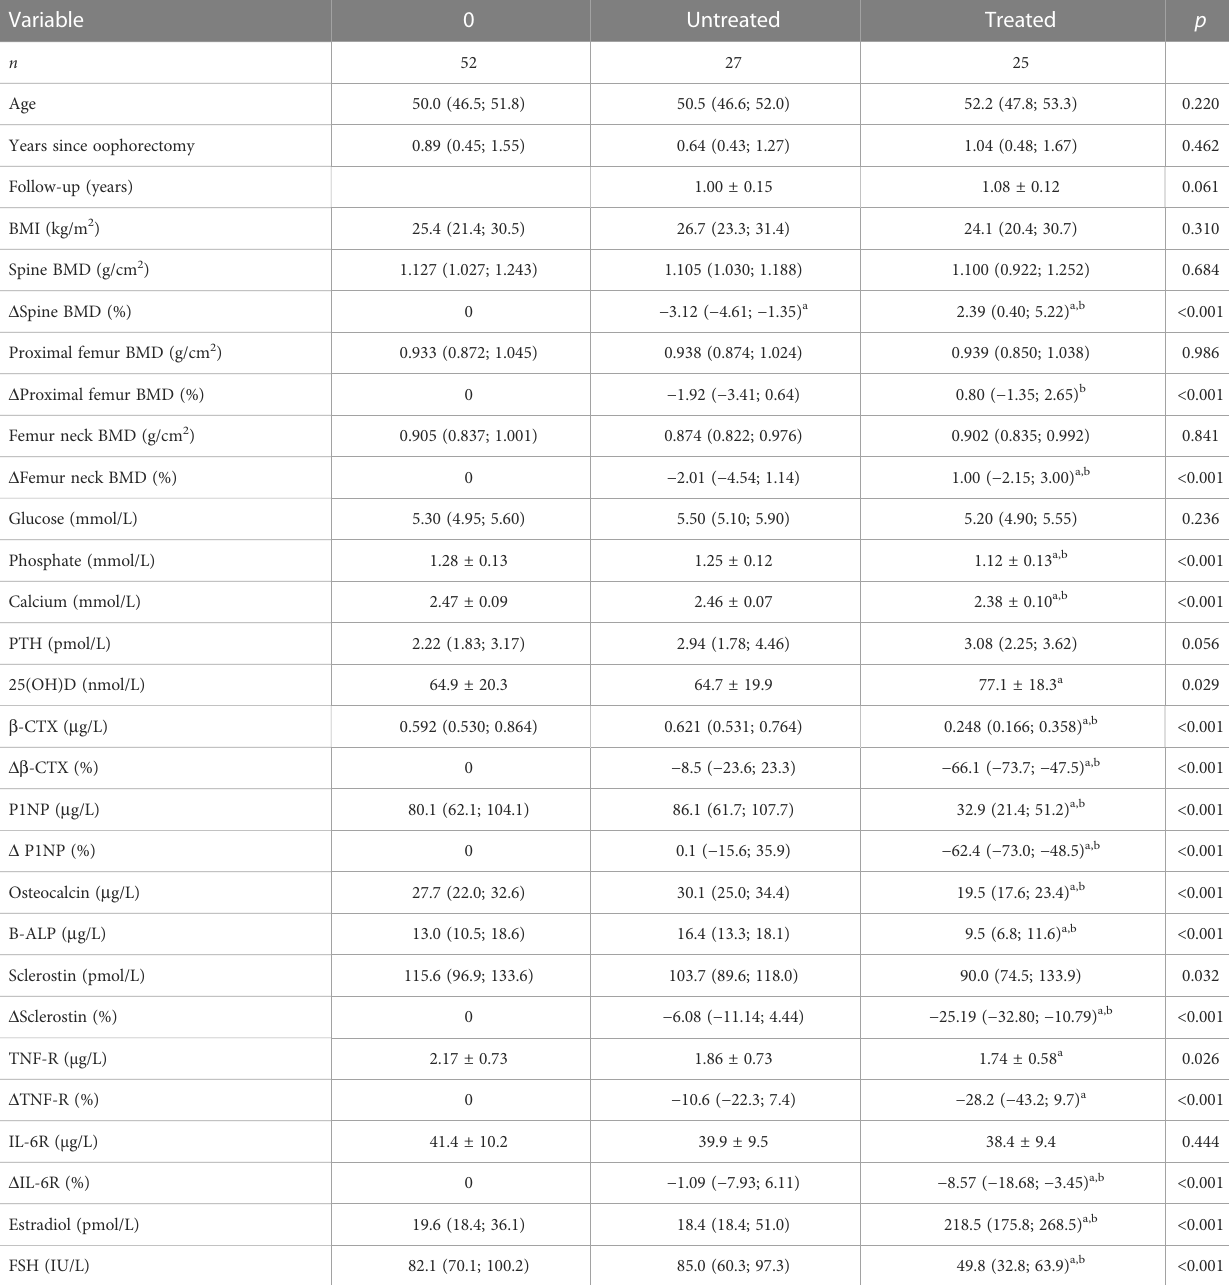
TABLE 2 Comparison of laboratory data in treated and untreated oophorectomized women.